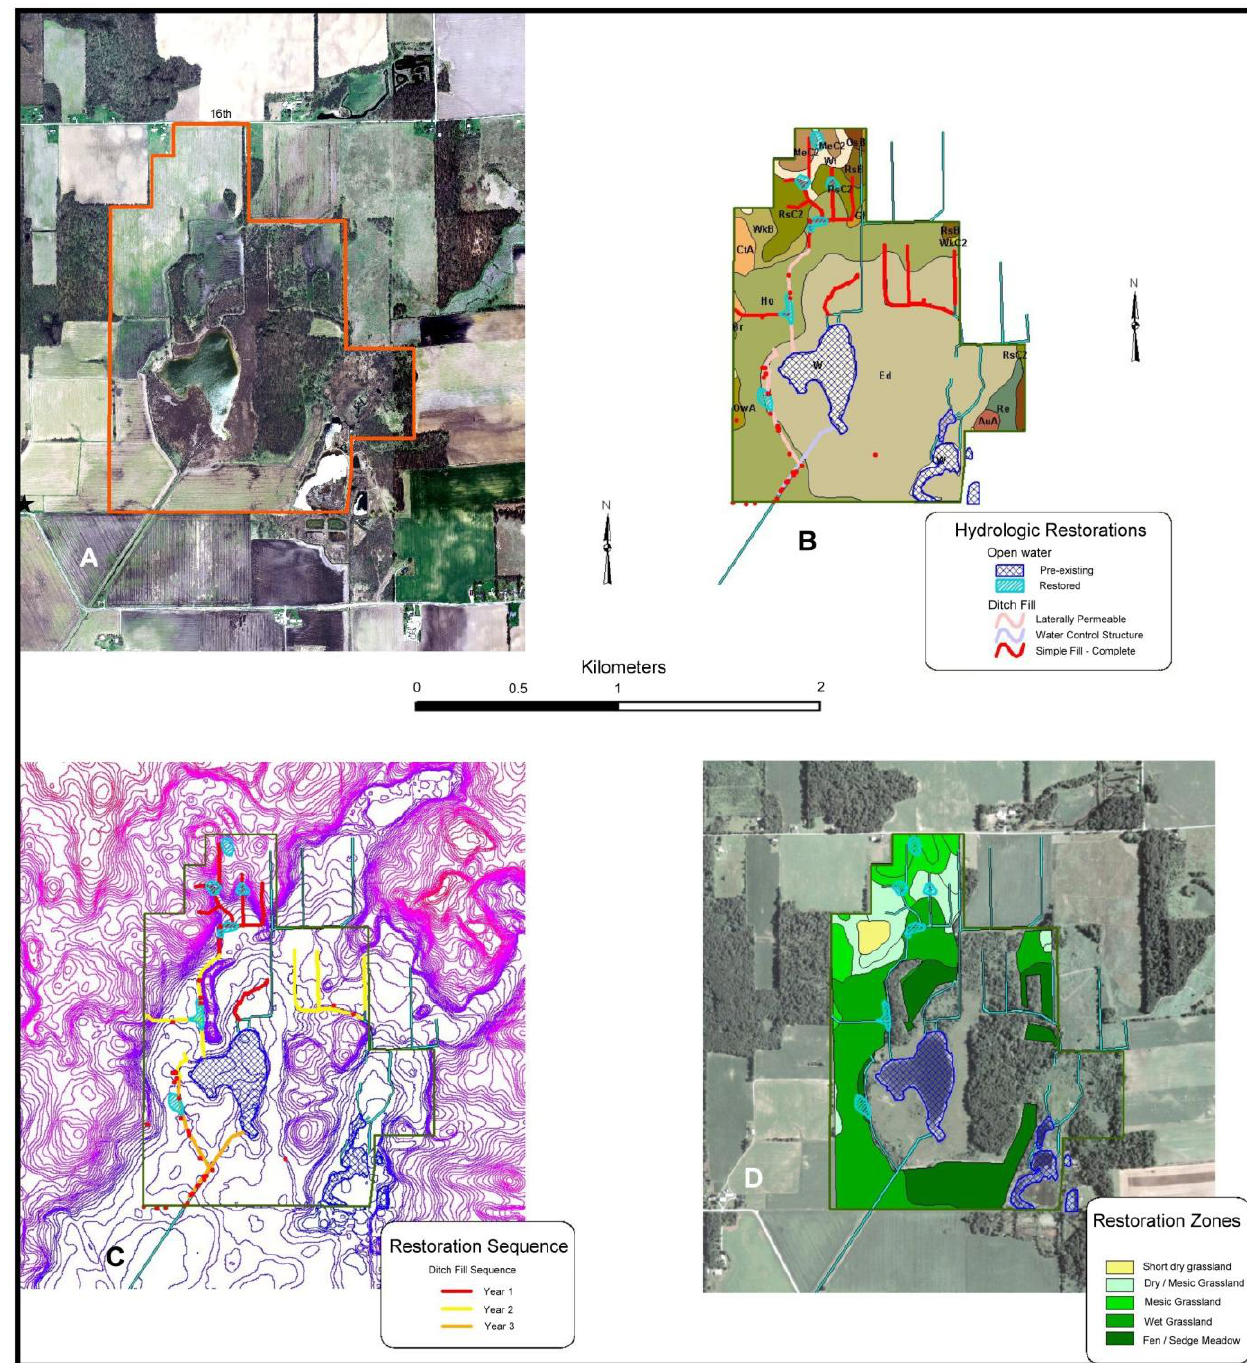
Figure 5. Houghton Lake restorations. The conservation site is embedded within a highly agricultural landscape ( A ) that required the installation of an extensive drainage network ( B ) of both open ditches and buried tiles to dry much soil in the wetland basin. These tiles diverted surface and subsurface water away from fen, sedge meadow and glacial lake habitats at the site. A detailed hydrologic restoration plan was developed ( C ) that enhanced groundwater flow to wetland habitats, which allow for the restoration of fen and sedge meadow habitats in wet muck soils in the wetland basin ( D